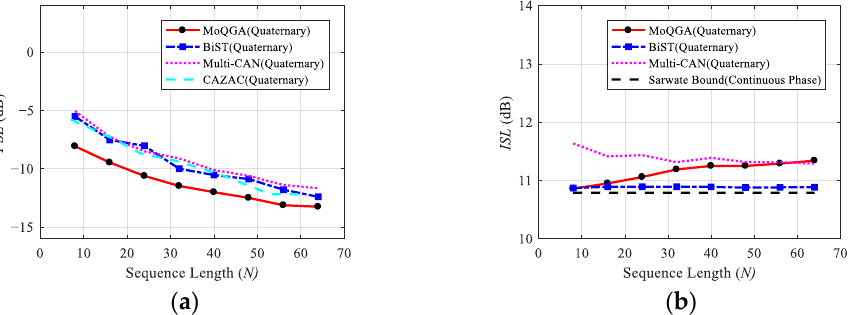
Figure 11. PSL and ISL values of MIMO radar quaternary phase code sequence set obtained by MoQGA and other methods under M = 4 and different code sequence length. ( a ) PSL ; ( b ) ISL .